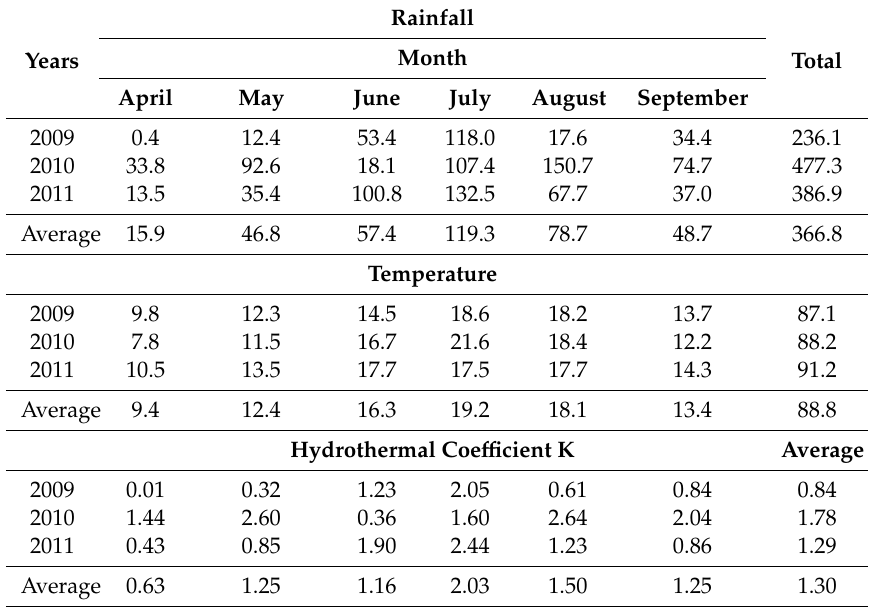
Table 4. Weather conditions during the plant growing season at the Mochełek Experiment Station.